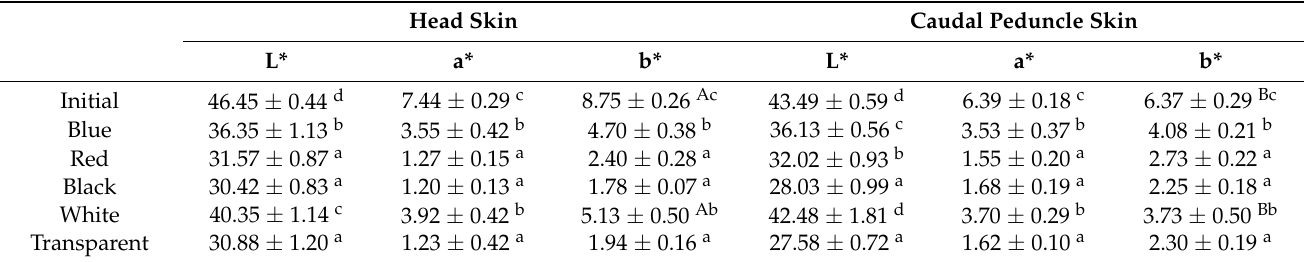
Note: Values are means ± standard error for ten replicates. Significant differences for means within experimental groups are indicated with different lowercase letter superscripts ( p < 0.05, n = 10); Significant differences for means between head skin and caudal peduncle skin groups are indicated with different capital letter superscripts ( p < 0.05, n = Table 2. Effects of background color on the L*, a*, and b* values of the dorsal and ventral skin. Dorsal Skin Ventral Skin